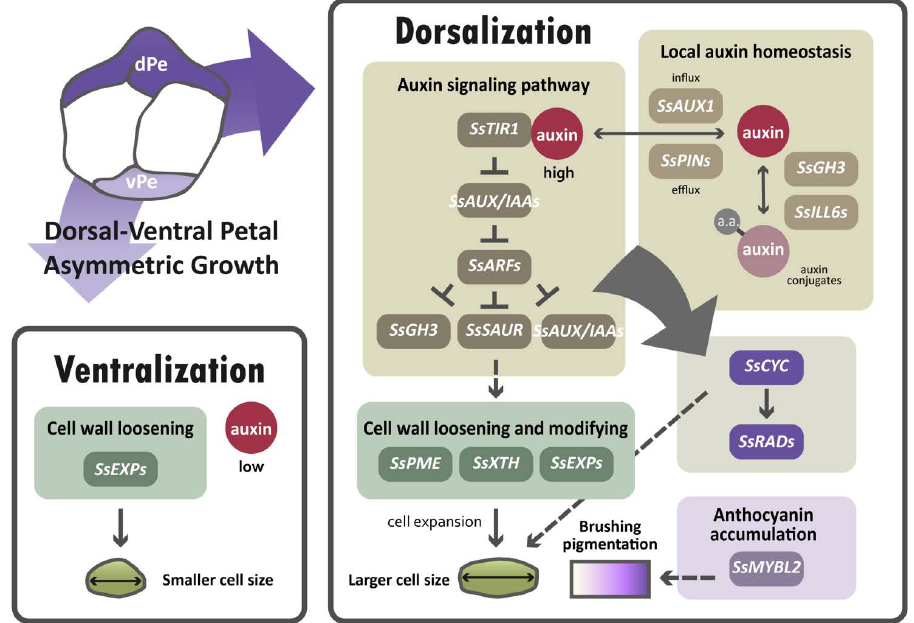
Figure 9. A hypothetical model proposed for the differential gene regulatory networks (GRNs) that determine dorsal–ventral petal asymmetry in zygomorphic S. speciosa ‘ES’. Solid lines represent direct or indirect regulation, and dashed lines indicate uncertain regulatory interactions. Dorsal petals, dPe; ventral petals, vPe.